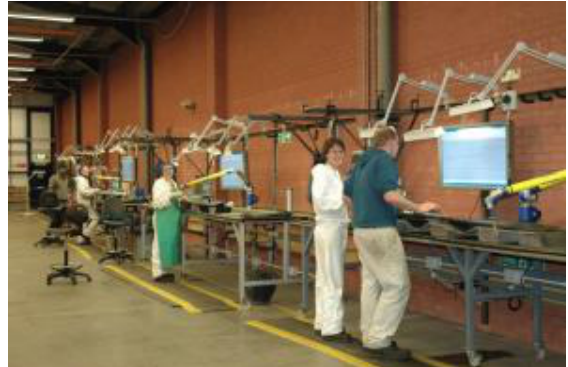
Figure 1. Four Documentation stations ©Newport Museums and Heritage